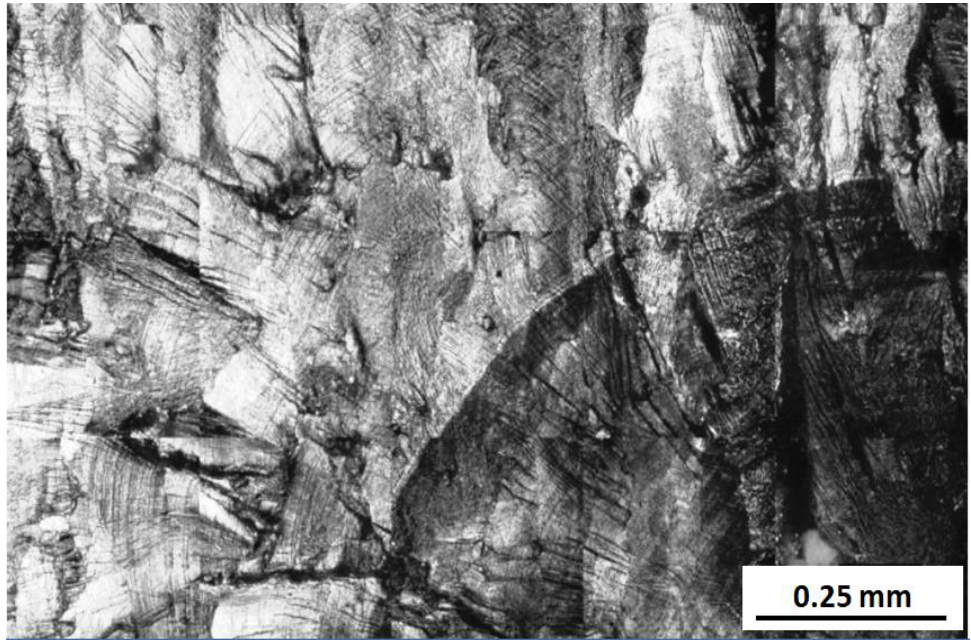
Figure 6. Optical fractograph for part of the C1 crack transition from service to test loading, from [14].